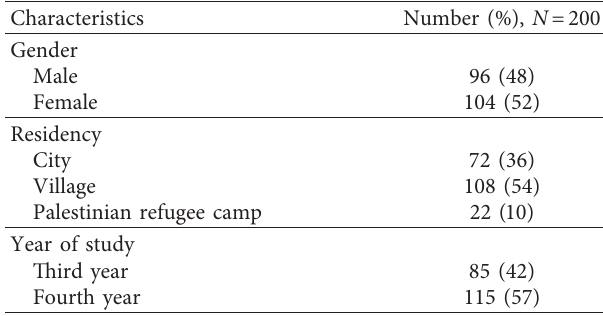
Table 1: Demographic characteristics of nursing students.